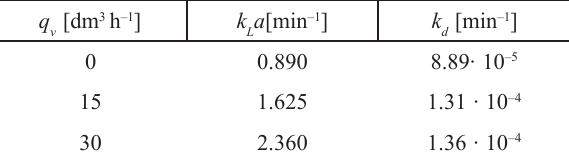
Fig. 7 – Glucose oxidation catalysed by immobilized GOD from Aspergillus niger in the batch reactor (c = 30–40 mM, glucose0 γ = 0.05 mg cm –3 , φ = 0.002, 0.1 M phosphate Eu– GOD Eu–catalase buffer pH = 7; 30 °C; V = 30 cm 3 ) without aeration (upper reactor graph: black circle – glucose, white circles –gluconic acid, x – glucono-δ-lactone; bottom graph – oxygen). Table 5 – Immobilized GOD operational stability decay rate constants at different aeration rates estimated from the inde- pendent activity